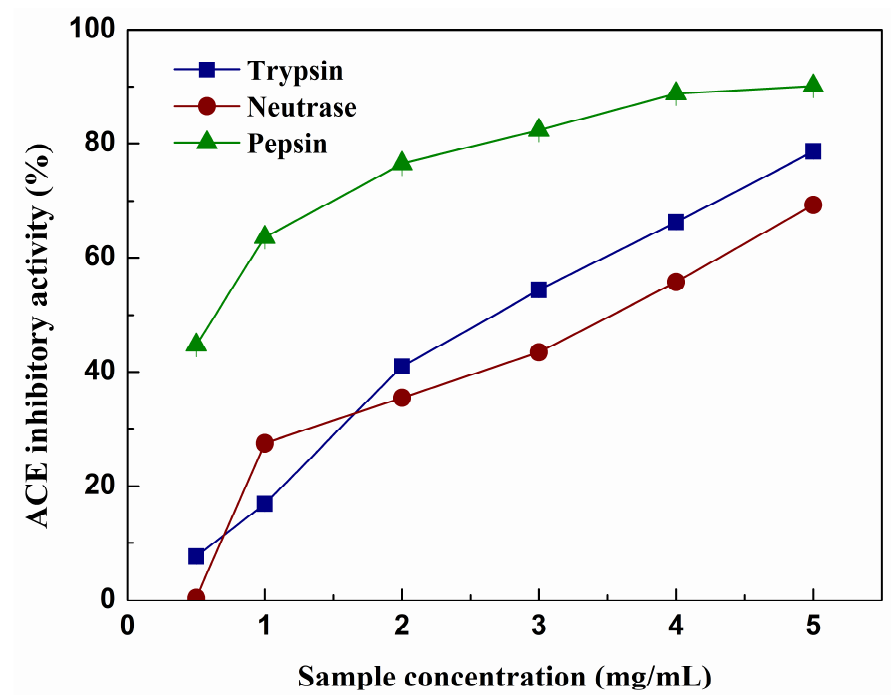
Figure 6. ACE inhibitory activity of the different hydrolysates during 4 h hydrolysis by trypsin, neutrase, and pepsin with different concentrations. Results represent means ± SD of three independent experiments.